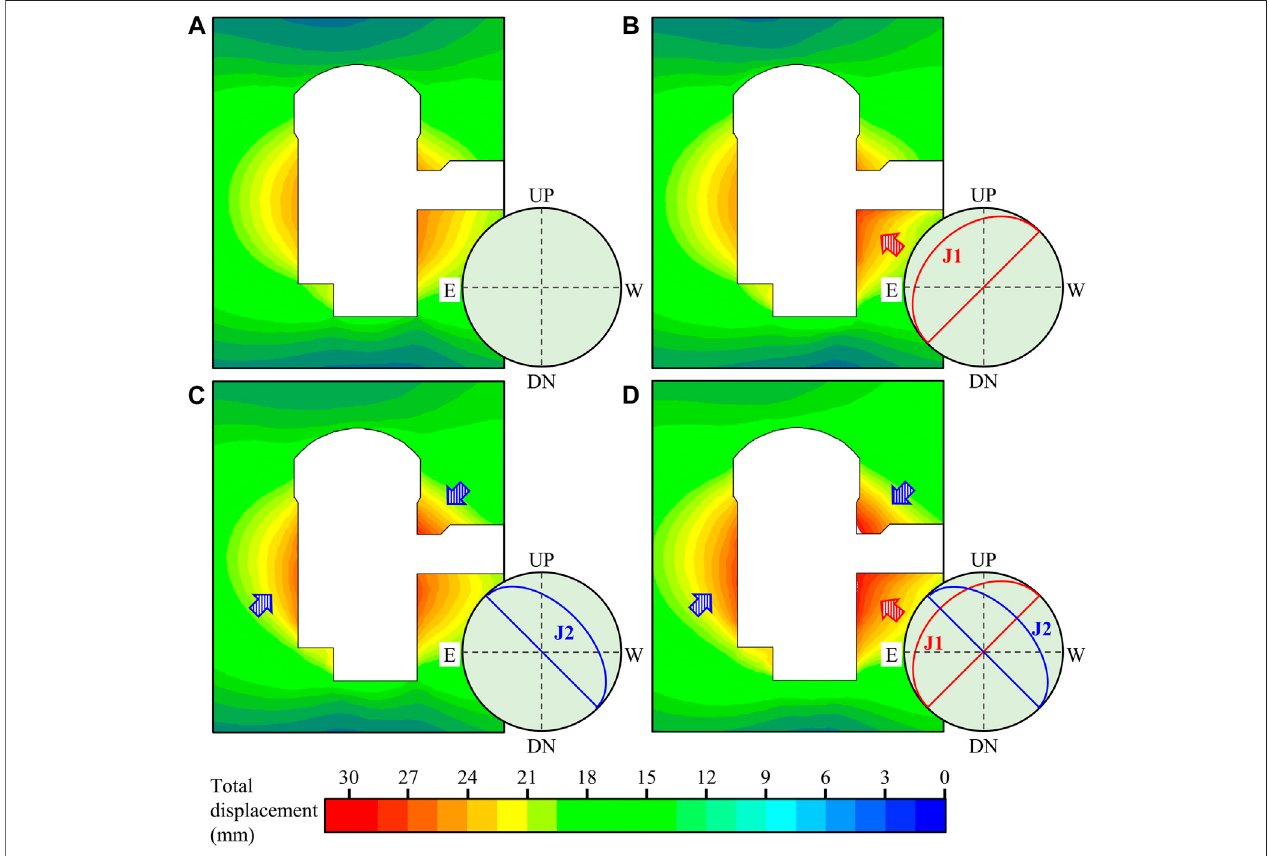
FIGURE 11 | Total displacement contours calculated using the (A) M – C model, (B,C) U-J model, and (D) enhanced model.